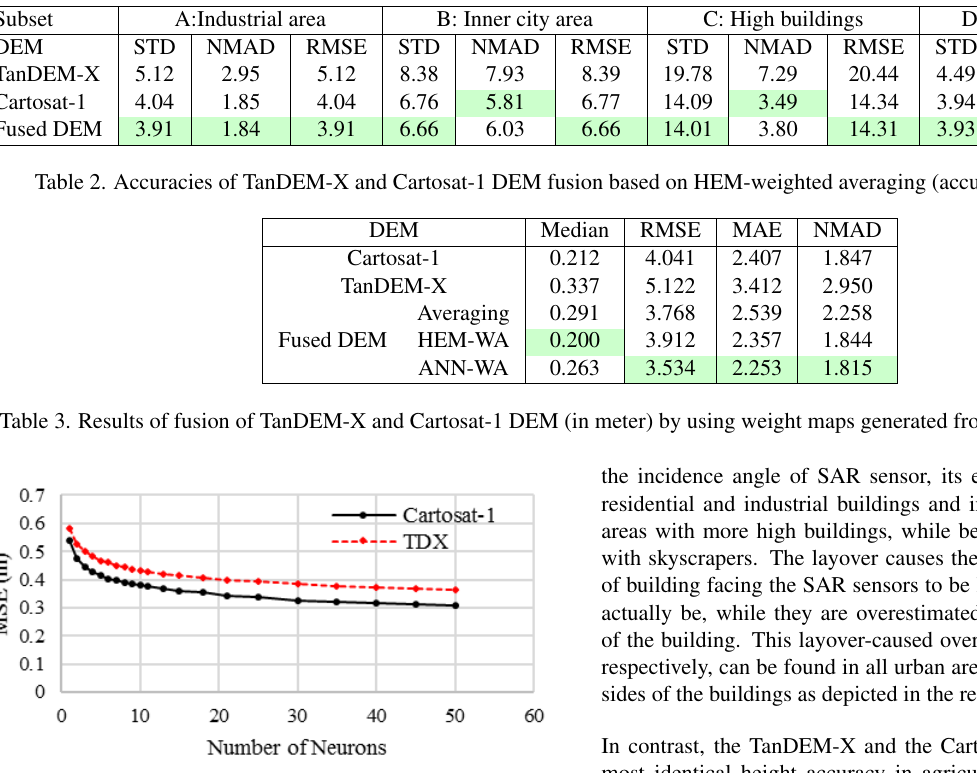
Figure 12. The performance of the NNs with increasing the number of Neurons in first layer